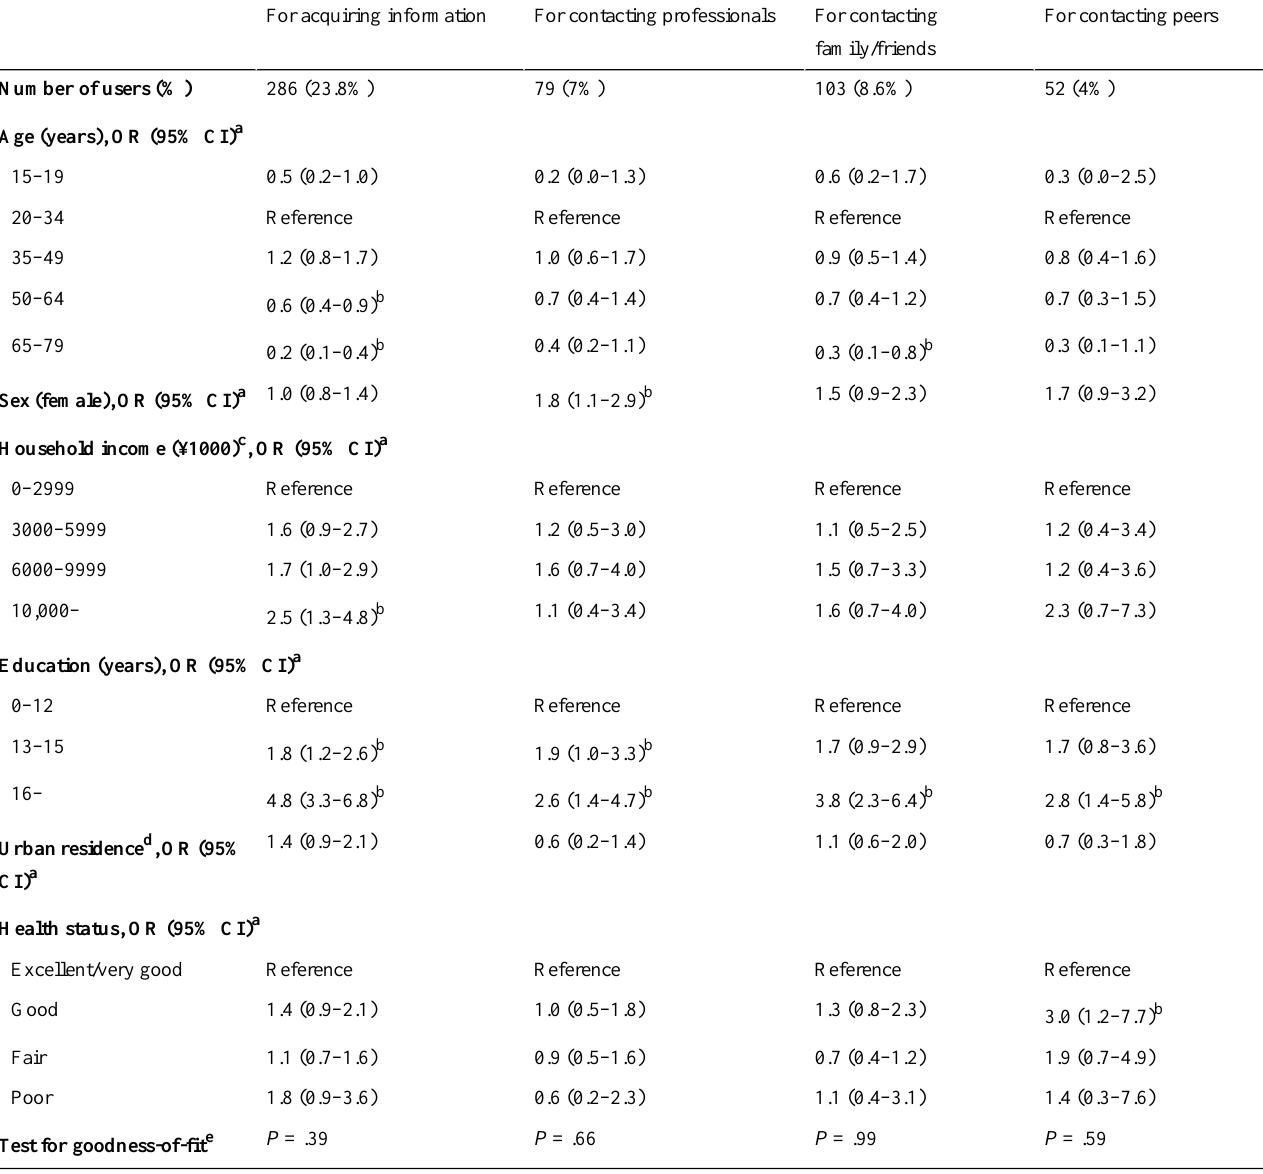
For contacting peersFor contacting family/friendsFor contacting professionalsFor acquiring